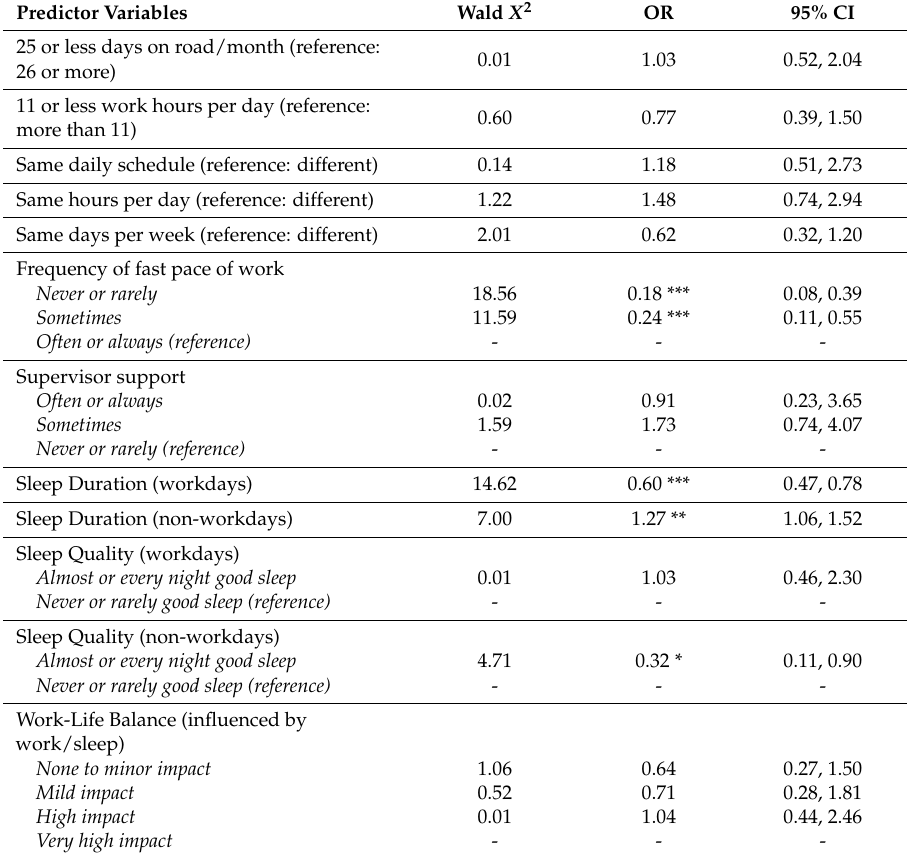
Table 5. Associations between Work Organization, Sleep, Work-Life Balance and Perceived Stress (controlled for age and length of